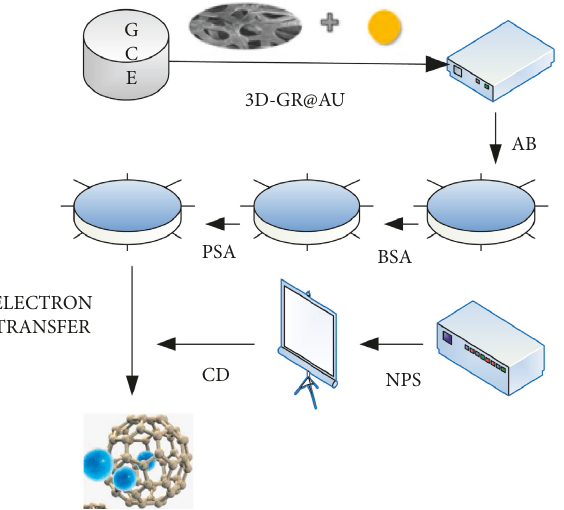
Figure 1: Fabrication process of the PSA sensor.